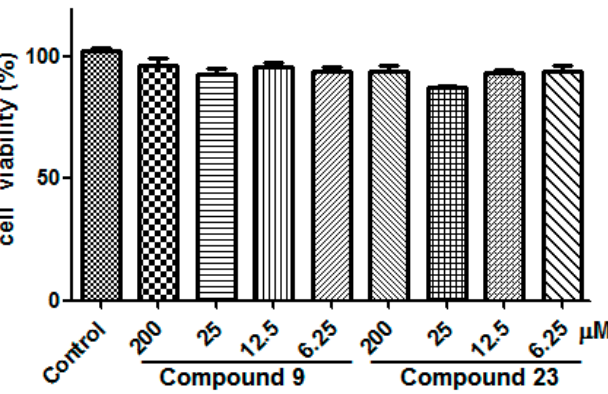
Figure 6. The cytotoxicity of 9 and 23 against SH-SY5Y cells. Date are expressed as the percent variation with respect to the viability recorded in control cells.